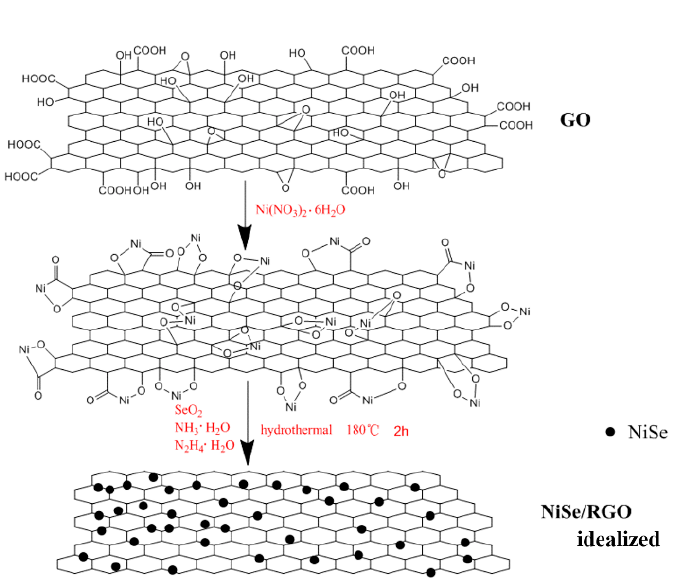
Figure 4. The illustration on growth processes of NiSe/rGO nanocomposites.